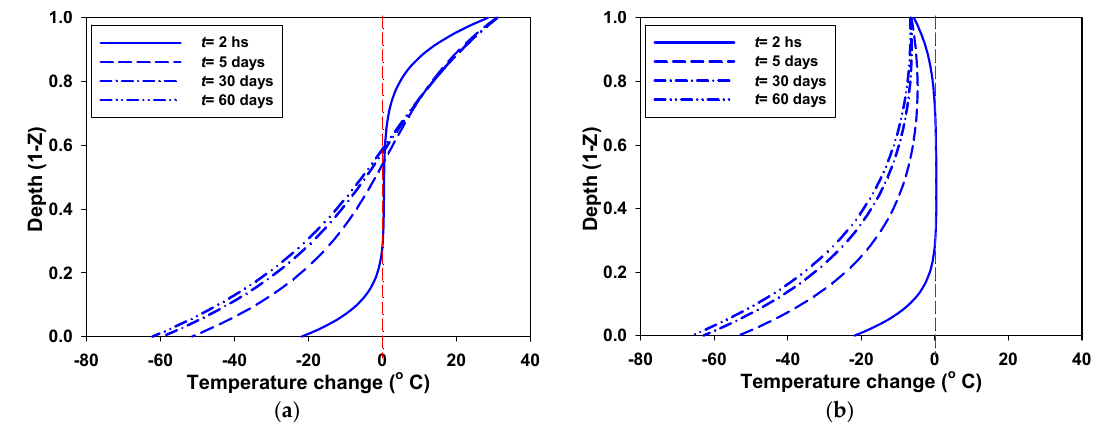
Figure 5. Fluid temperature change along the wellbore for a range of injection temperatures: ( a ) T in* = 56.5 °C; and ( b ) T in* = 16.5 °C.